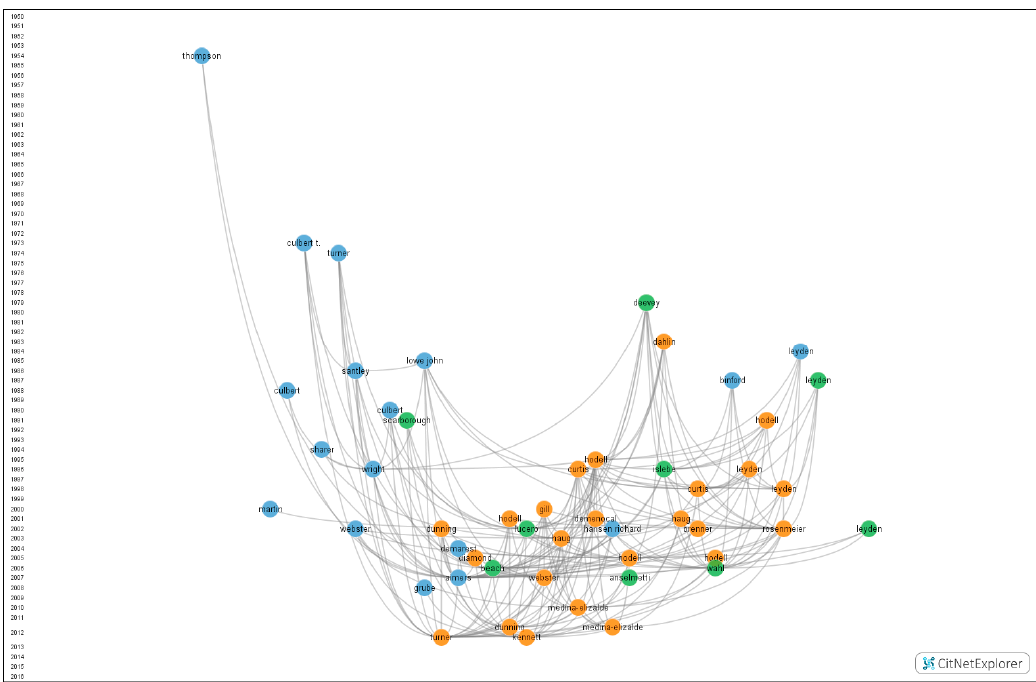
Figure 6. Citation network of the 50 most-frequently cited references out of 433 Maya collapse papers (including the non-matching cited references) with a minimum frequency of 10. Light blue: publications with no focus on climate. Light green: publications with a more indirect relation to climate change, dealing for example with agriculture, soil erosion, deforestation, and vegetation history. Orange: publications with a direct relation to climate as a driving force, mostly based on paleoclimatic records. The classification is based on content analysis of the papers and the coloring has been performed by the corresponding software function. Source: WoS, CitNetExplorer.